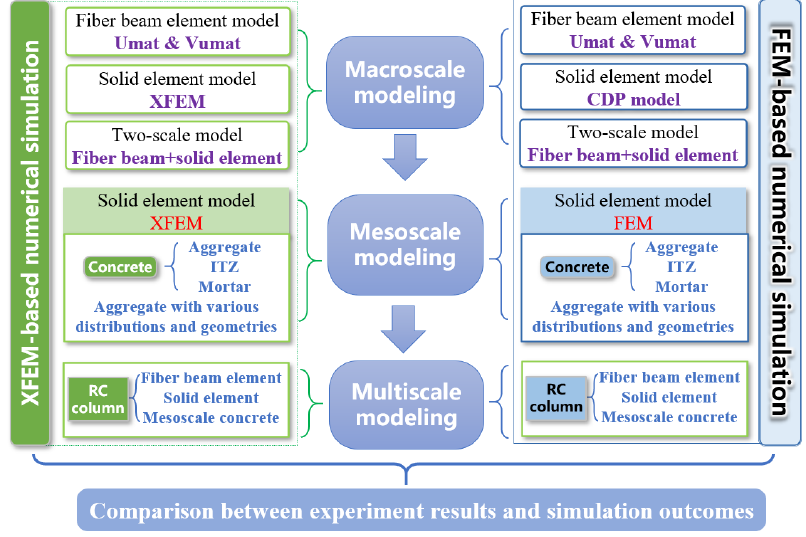
Figure 4. Flowchart of modeling methodology for multiscale simulation.